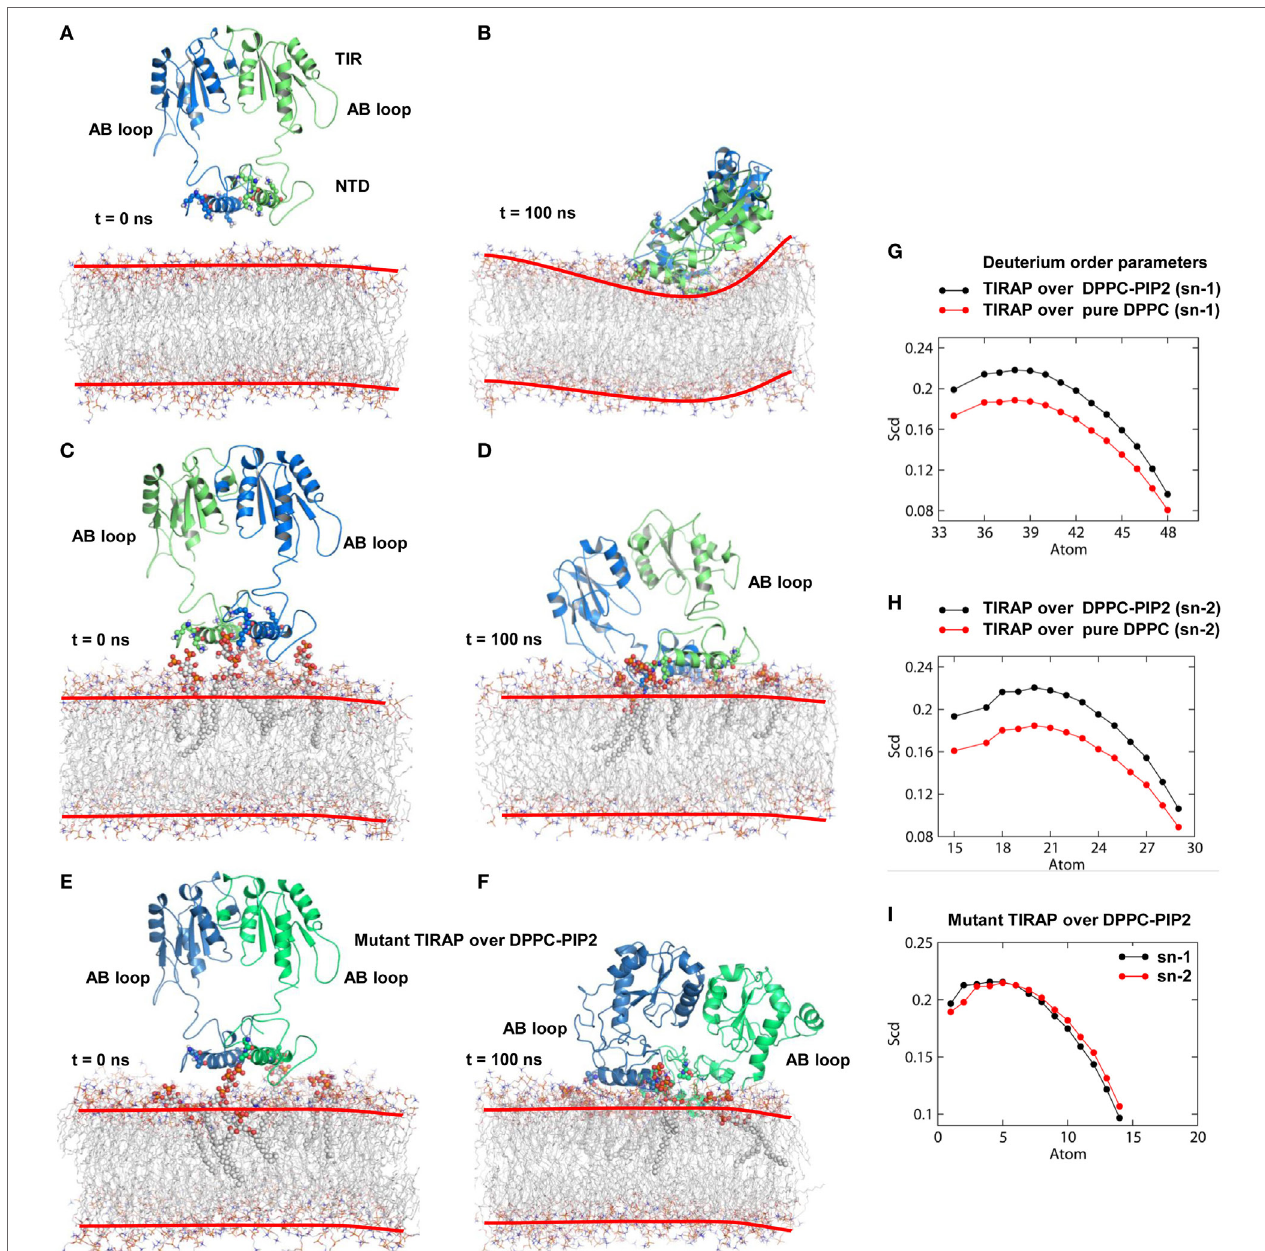
FigUre 4 | Molecular dynamics (MD) simulation of toll/interleukin 1 receptor domain-containing adaptor protein (TIRAP) over different dipalmitoylphosphatidylcholine (DPPC) bilayers. (a) Starting model of TIRAP over a pure DPPC bilayer. (B) The last snapshot of TIRAP ( t = 100 ns) over the DPPC-only bilayer. The curvature of the membrane surface is marked with red lines for clarity. (c) TIRAP model over a DPPC–phosphatidylinositol (PI) 4,5-bisphosphate (PIP2) bilayer. The PIP2 and PI-binding residues are represented as solid spheres. (D) TIRAP model after 100 ns of MD simulation over a DPPC–PIP2 bilayer. (e) Initial model of the mutant TIRAP (K15 → A, K16 → A, K31 → A, and K32 → A) over the DPPC–PIP2 bilayer. (F) 100 ns snapshot of the mutant TIRAP. In each panel, chain A is colored blue and chain B is green. (g) Deuterium order parameter of sn-1 chains of DPPC lipids. (h) Deuterium order parameter for sn-2 chains. In both G and H, black lines represent order parameters of PIP2-bound DPPC, while red lines represent order parameters of pure DPPC lipids. (i) Order parameters of DPPC–PIP2 bilayer under the mutant TIRAP. Black and red lines represent sn-1 (carbons 34–50) and sn-2 (carbons 15–31) chains, respectively.